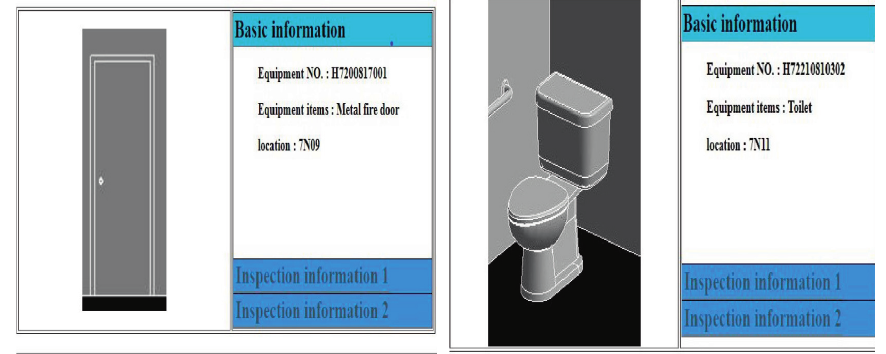
Figure 7: The sample menu of the facility’s traceability information.